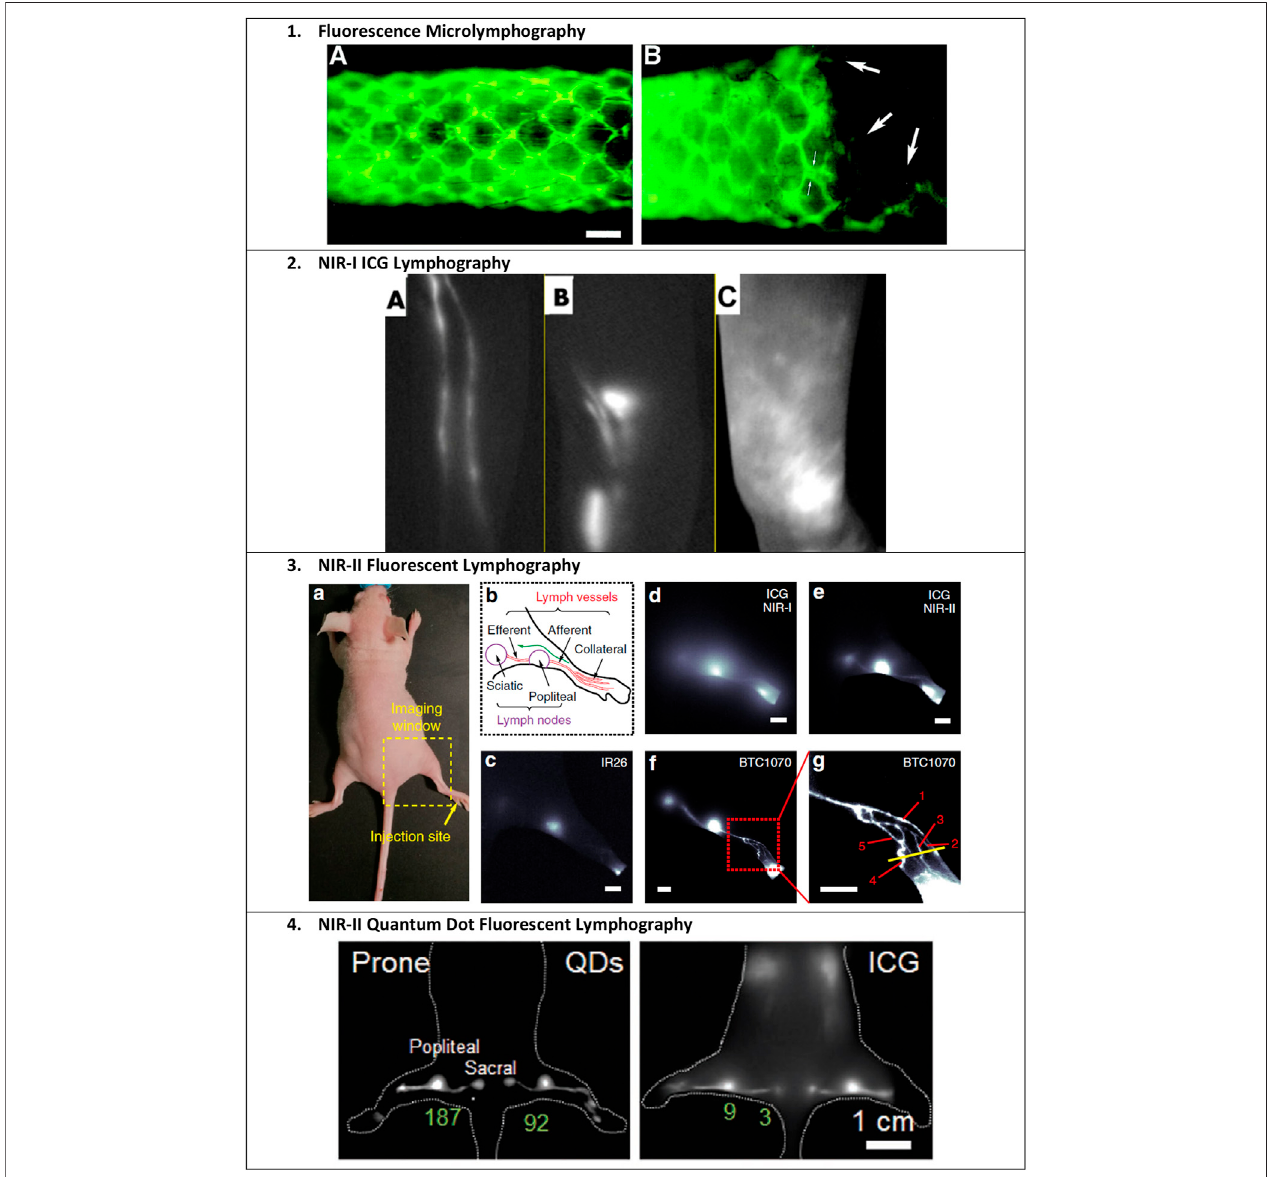
FIGURE 3 | Examples of fl uorescent lymphatic imaging. 1) Fluorescence microlymphography (FML) of the nude mouse tail after the injection of 5 μ L of 25% 2,000 kDa FITC-dextran at the distaltip. The direction of lymph fl ow isfrom left toright. Bar, 400 μ m. (A)Typical continuous lymphatic network 22 min after injection. (B) Same tail, 28 days after injection of an FSaII cell suspension. Large arrows indicate attenuated vessels possibly inside the tumor. Small arrows indicate the increased apparent diameter due to engorgement and/or fl attening ofthe lymphatic capillary. Reproduced with permission from Leu et al.(2000). 2) ICG lymphography. Left- arm of a 38-year-old woman with left breast cancer who underwent a mastectomy and axillary lymph node dissection. (A) Before surgery with no edema. ICG lymphography showed a linear pattern. (B) Three months after surgery. Although the patient complained of a heavy feeling in the left upper arm, signi fi cant limb volume changewasnotseen.Asplashpatternwasobservedontheleftupperarm.(C)Twelvemonthsaftersurgery.Theleftarmbecamesigni fi cantlylargerclinicallydespitethe use of a compression sleeve. A stardust pattern was observed throughout the left arm. Reproduced with permission from Akita et al. (2016). 3) NIR-II fl uorescent lymphography. Images demonstrate the superior resolution of imaging ICG in the NIR-II range and of BTC-1070 compared to ICG and IR26. (a) Digital photograph of a nude mouse fi xed on an imaging plate, showing the injection site (yellow arrow) of contrast agents and the lymphatic drainage imaging window (dash square). (b) Schematic illustration of the anatomical structure of the lymphatic system in the hindlimb of nude mice; the green arrow represents the lymphatic drainage from the paw to the sciatic lymph node. (c – g) Fluorescence images of lymphatic drainage using IR26 (c), ICG (d, e), and BTC1070 (f, g) in the hindlimb of nude mice on an InGaAs camera. (g) High-magni fi cation (×3) image of the ankle (red square in f), showing that at least fi ve collateral lymph vessels were resolved. Scale bar, 2.5 mm IR26 and BTC1070 imaging signals were collected at wavelengths of 1,200 – 1,700 nm under 1,064 nm excitation. ICG was excited at 808 nm, and images were collected in the NIR-I (850 – 950 nm) and NIR-II (1,000 – 1,700 nm) regions, respectively. Reproduced with permission from Wang et al. (2019). 4) NIR-II quantum dot fl uorescent lymphography. Mouse footpads were injected with 50 μ L ultrabright PbS/CdS core/shell quantum dot solution (100 pmol). Shown is a comparison of popliteal and sacral lymph nodes imaged with QDots at the NIR-IIb window and ICG at the NIR-I window, respectively. The signal intensity of LNs is labeled with values in green. Reproduced with permission from Tian et al. (2020).